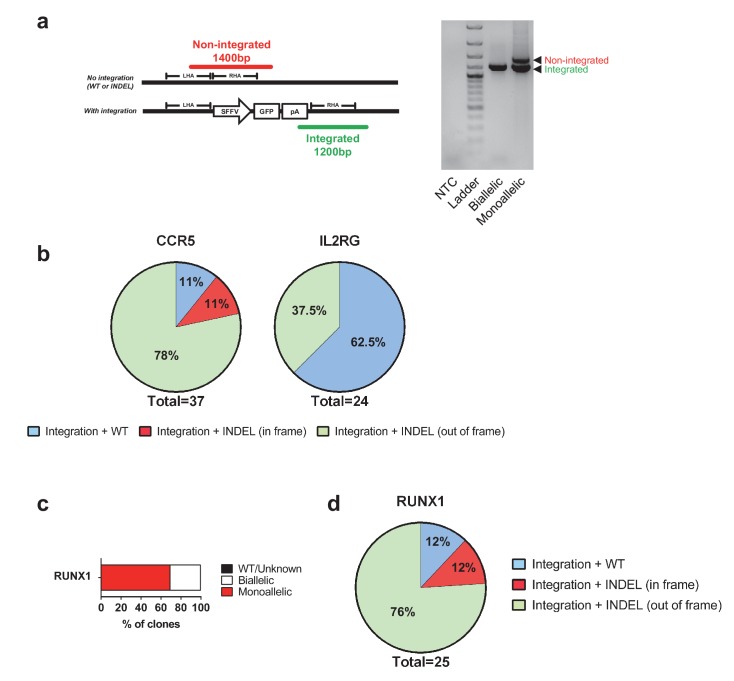
Genotypes of clones with mono-genic targeting.(a) Left, schematic representation of the three-primer PCR used to genotype CCR5 alleles for integrated (green PCR product) and non-integrated (red PCR product) alleles. One forward primer is located in the left homology arm (LHA), one forward primer is located in the poly A, and a common reverse primer is located outside the region of the right homology arm (RHA). Right, gel image of representative genotyped clones from Figure 1c (CCR5) showing colonies with biallelic and monoallelic integrations. (b) A subset of the CCR5 and IL2RG clones (only female cells for IL2RG) from Figure 1c with monoallelic integration had the genotype on the non-integrated allele analyzed by Sanger sequencing of purified PCR products. Note that in-frame INDELs can be gene-disrupting depending on the location and size of the INDEL. (c) As in Figure 1c, HSPCs were targeted at RUNX1 and at day four post-electroporation, reporterhigh cells were single cell-sorted into methylcellulose-containing 96-well plates to establish colonies. After 14 days, PCR was performed on colony-derived gDNA to detect targeted integrations. A total of 36 myeloid and erythroid methylcellulose colonies were screened. (d) The monoallelically targeted clones from c) had the genotype assessed on the non-integrated allele by Sanger sequencing of purified PCR products. See Supplementary file 1b for complete list of genotypes.